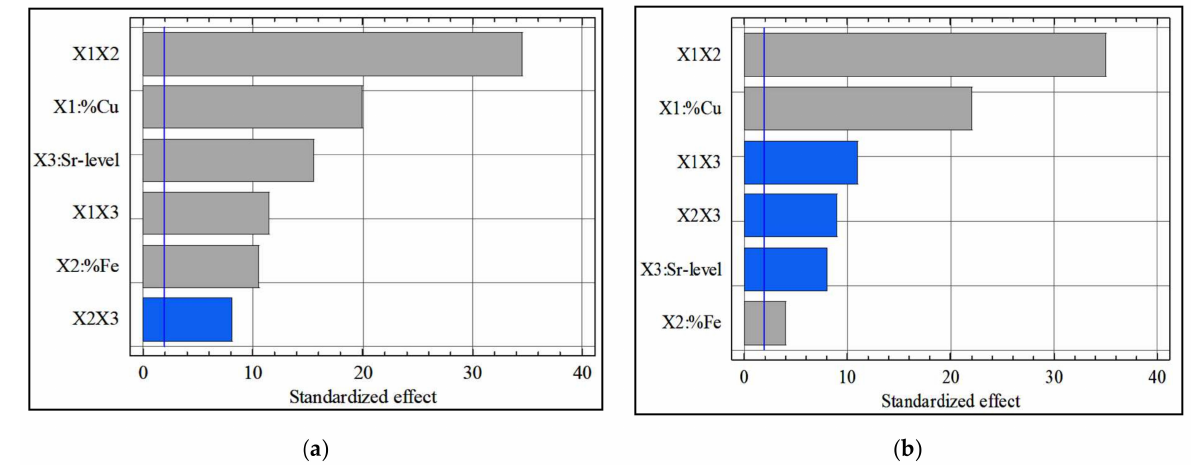
Figure 2. Pareto charts of the standardized effects for ( a ) yield stress data and ( b ) ultimate tensile strength data.